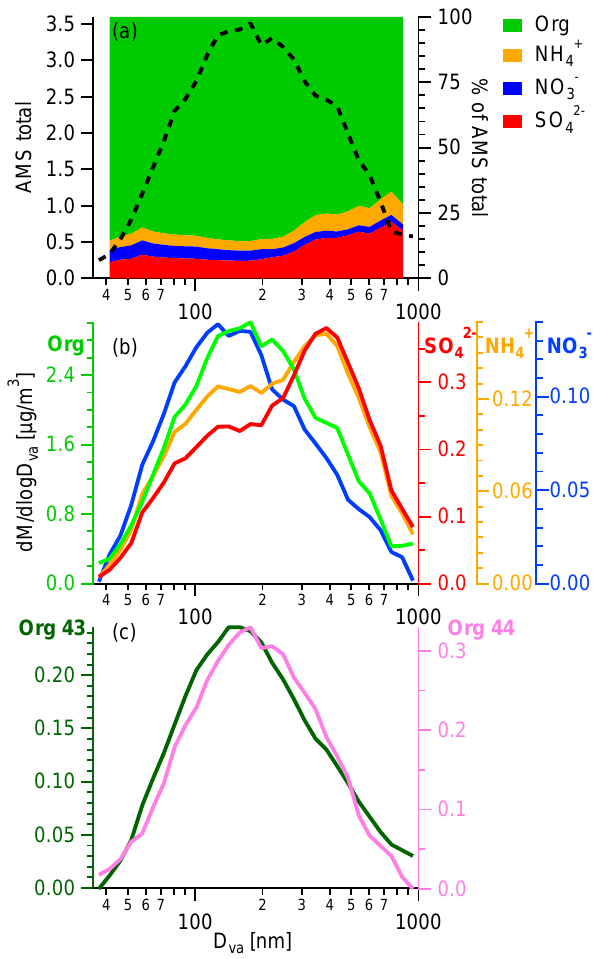
Fig. 6. (a) Average size distributions of the AMS total mass and percentage contribution of aerosol species to total mass, (b) average size distributions of aerosol species, and (c) average size distribu- tions of organic aerosol signals at m / z 43 and m / z